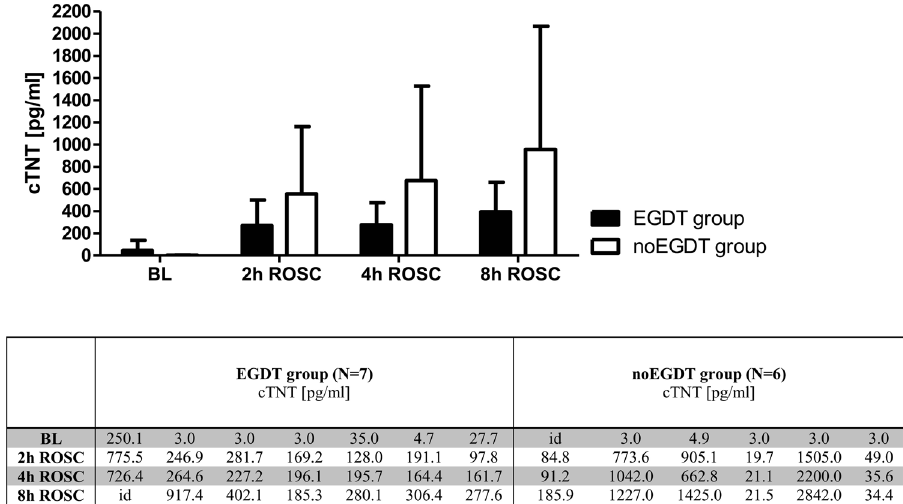
Figure 4. Mean concentrations of plasma cTNT at baseline, 2 h, 4 h and 8 h after ROSC in the EGDT and noEGDT group (upper panel). Columns show the mean, bars denote SD. cTNT values for each animal are depicted in the table (lower panel). Id invalid data.